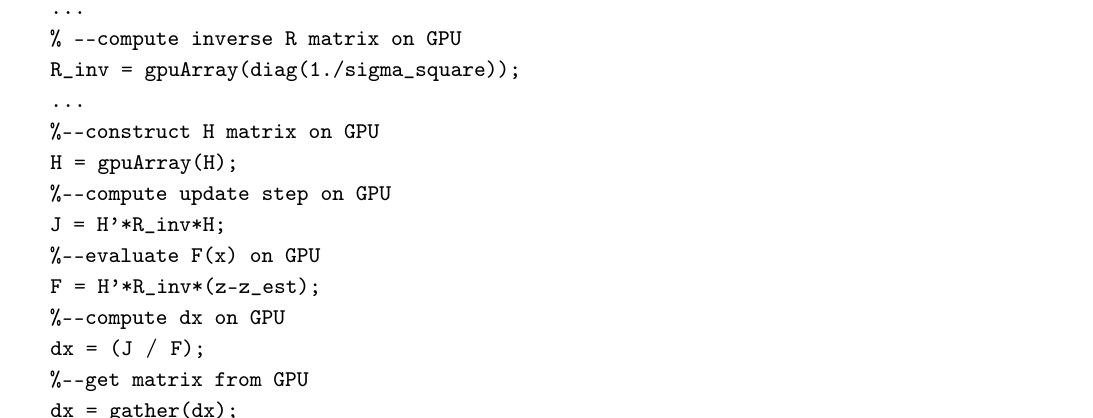
Algorithm 1: Modified code of MATPOWER [33] State Estimation (SE) function doSE.m for performance improvement using Graphical Processing Unit